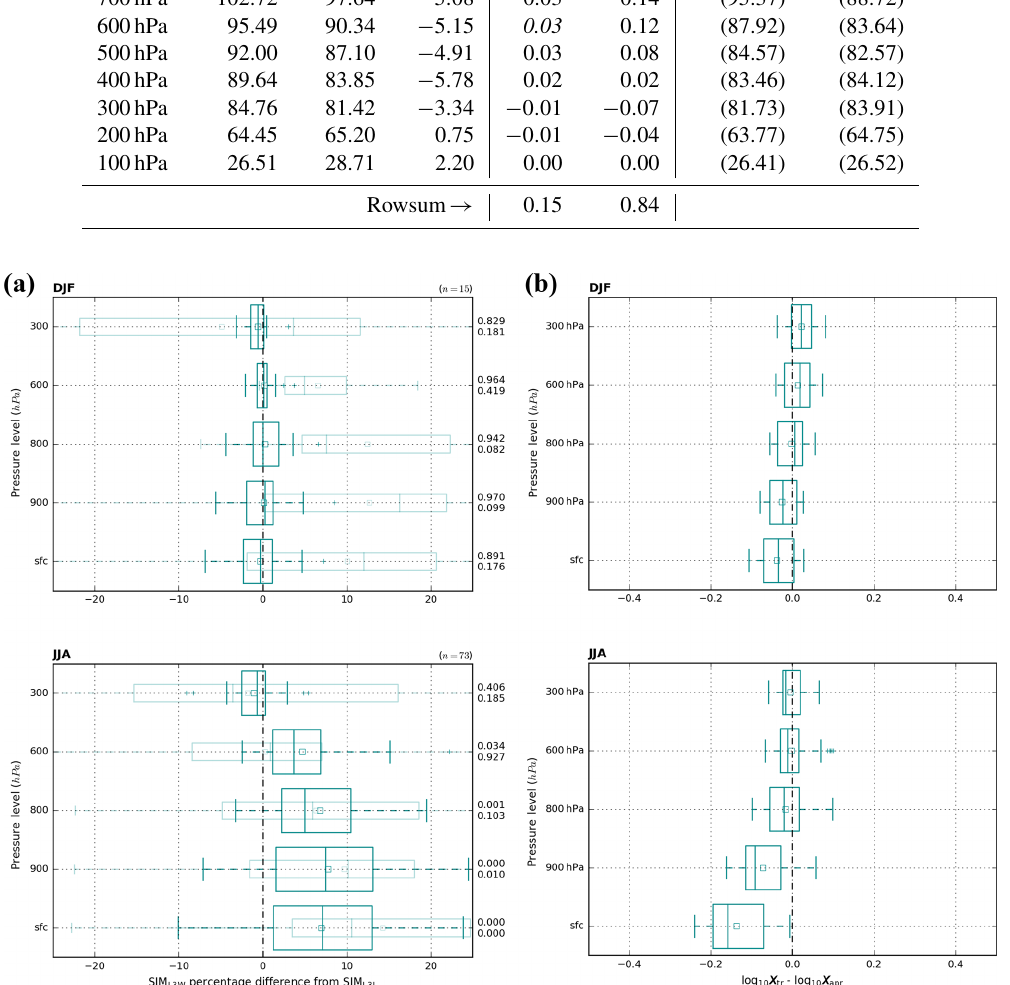
(cid:110)(cid:16) L3W (cid:17) (cid:111) · 100 − 100) between simulated L3L